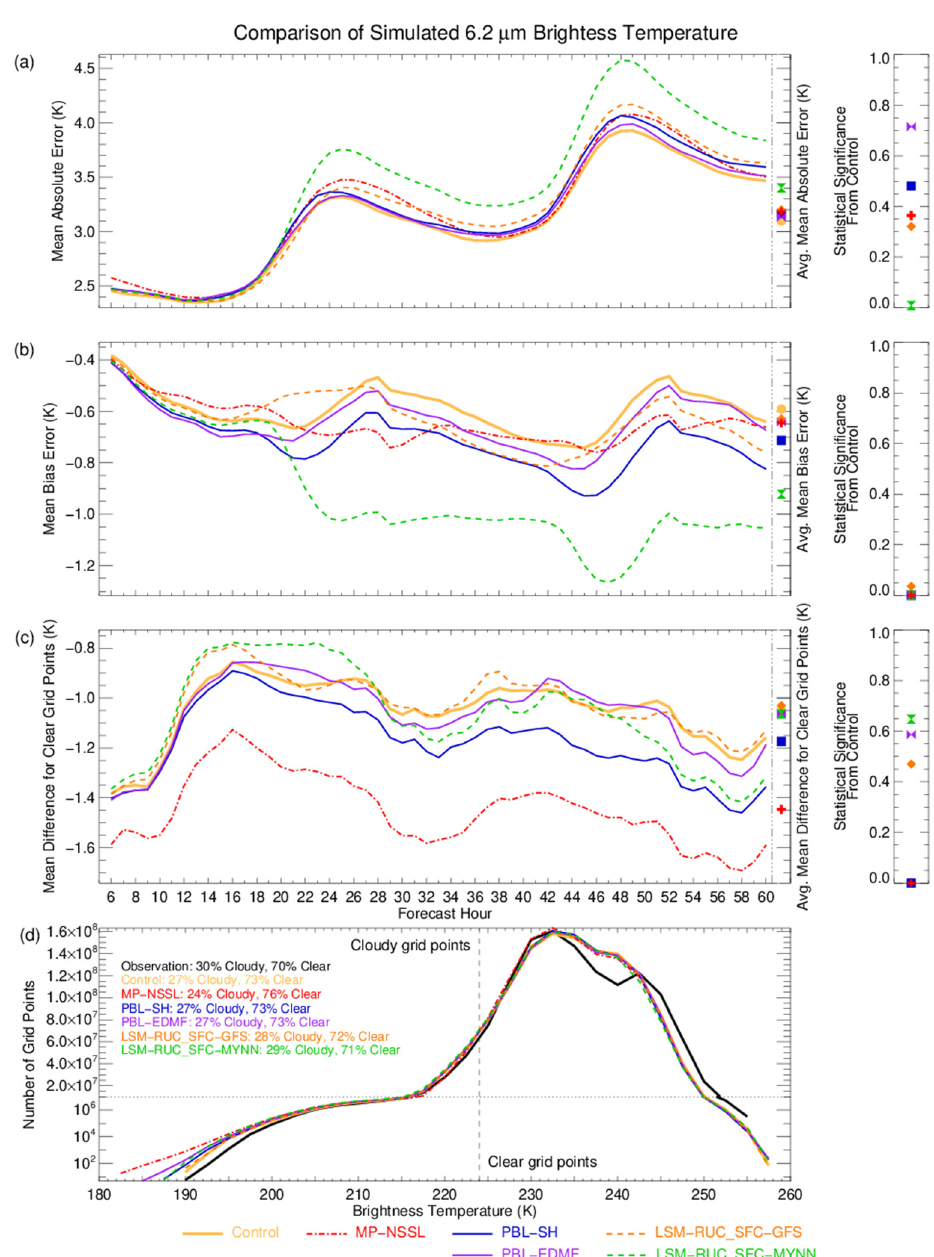
Figure 2. Line plot of GOES-16 6.2 µ m brightness temperature: ( a ) mean absolute error, ( b ) mean bias error, ( c ) mean difference for clear grid points, and ( d ) distribution of number of grid points by brightness temperature for configurations employed during the 2019 Hazardous Weather Testbed. The colored symbols on the right side of ( a – c ) show the average errors for each configuration over the entire time series and the statistical significance from Control. The delineation between cloudy and clear grid points in ( d ) is the lowest observed clear ‐ sky BT, averaged over all forecast initializa ‐ tions and hours.